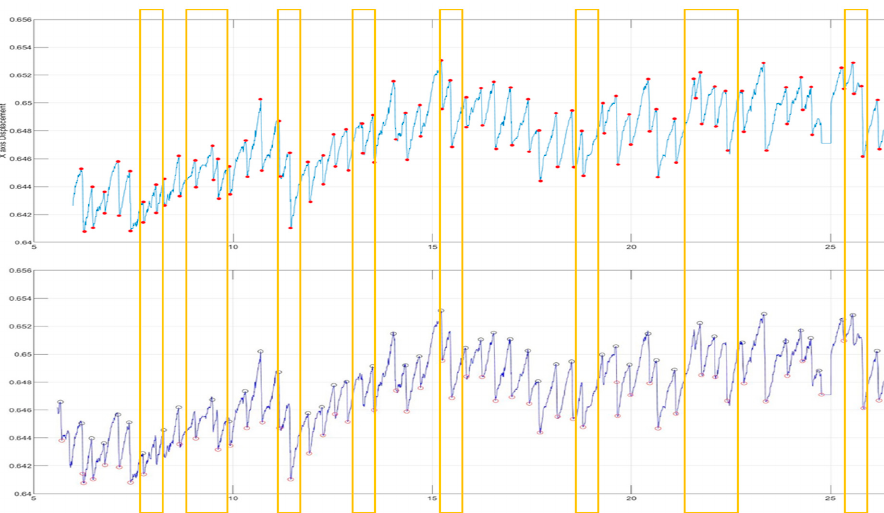
Figure 12. After the high-pass filtering and threshold setting, the yellow box represents the interval where FP points are not captured.